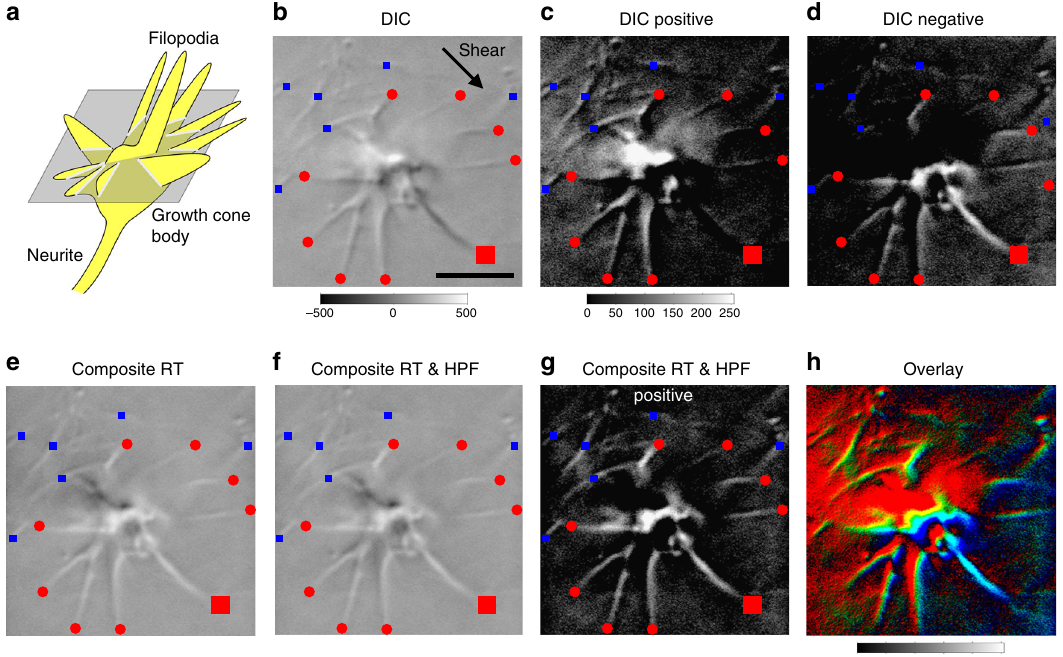
Fig. 2 Composite RT-based conversion of a growth cone DIC microscopic image. a Schematic of a growth cone growing upward (yellow) and its optical section (light gray) in a focal plane (gray) with a DIC microscope. b DIC microscopic image capturing the frontal view of a neuronal growth cone embedded in collagen gels. Radially extending fi lopodia (red circles and a red square) and collagen fi bers (blue squares) are visible. c Thresholding of b by positive values. d Thresholding of b , showing negative intensity only. e , f The composite RT of b without e or with f high-pass fi ltering. All fi ber structures including a 45°-oriented dark fi lopodium (red square) are converted to bright objects without shadows. Note that shading bias in the upper-left quadrant in e is removed in f . g Self-luminous image obtained by thresholding of f . h Overlay of c (red), d (blue) and g (green). Data from cell #2. Scale bars, 5 μ